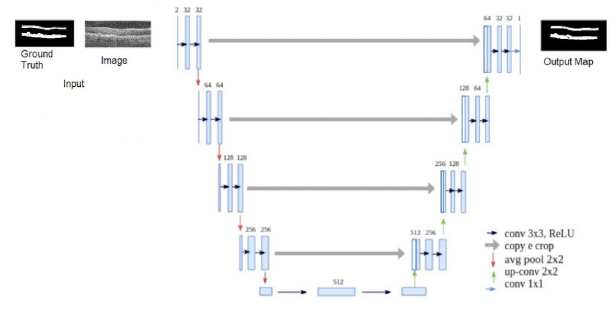
Fig 5. The used U-Net